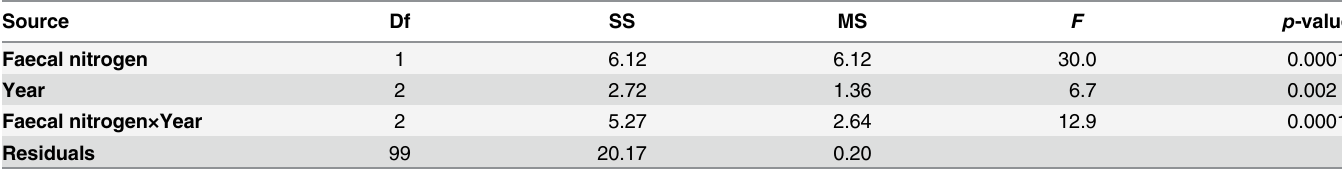
Table 1. ANCOVA results. Observed and fitted relationship between potential dietary N of Pyrenean Rock Ptarmigan (response variable) and the continu- ous variable free-urate faecal N (Faecal nitrogen) in the years 2002, 2003 and 2004 (factor Year).